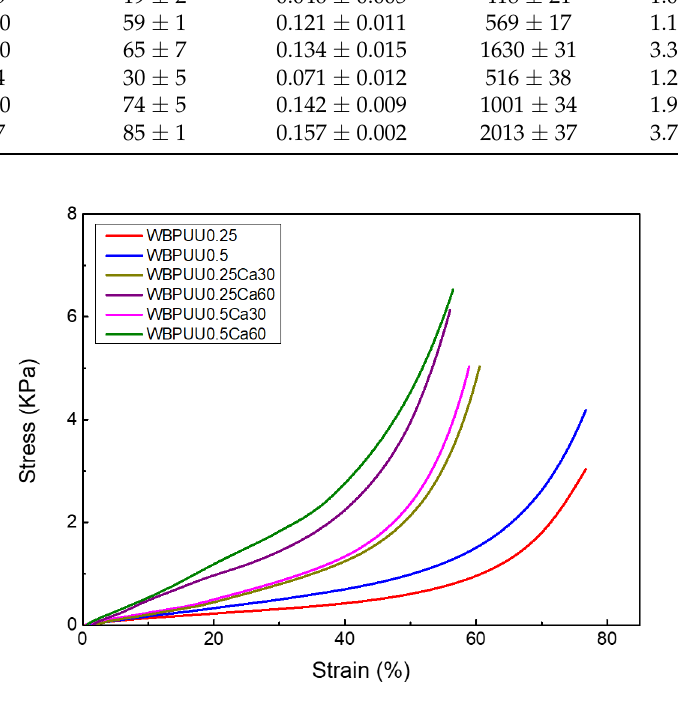
Figure 9. Stress–strain compression curves of WBPUU/CNC and WBPUU/CNC/CaCl 2 scaffolds. Table 4. Density, compression properties, and specific compression properties of the WBPUU/CNC prepared scaffolds.